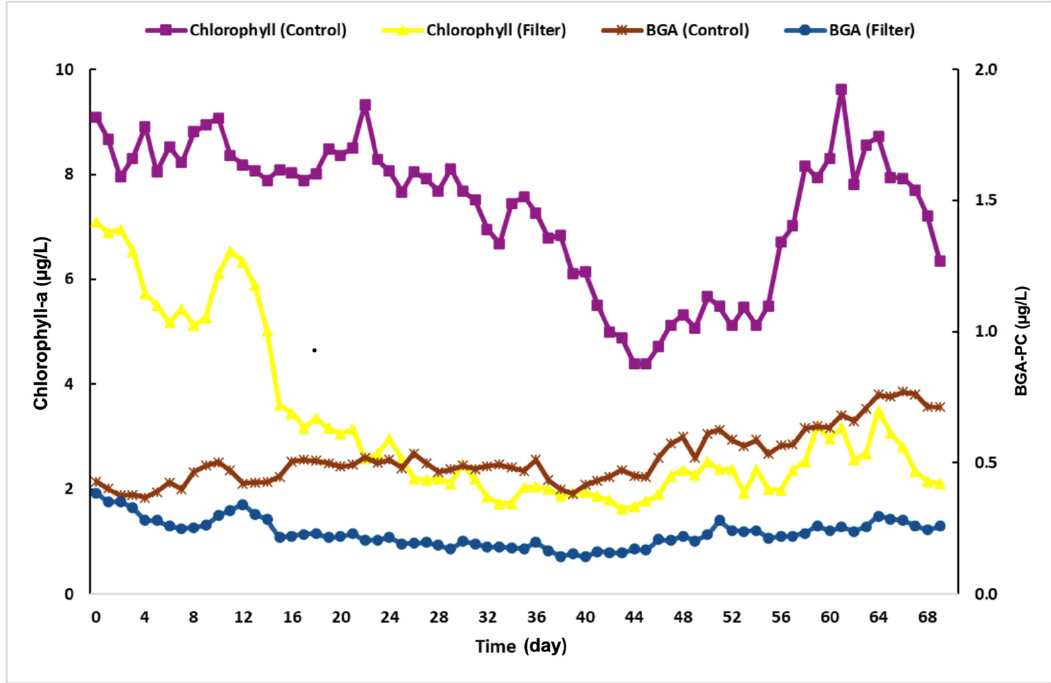
Figure 14. Chlorophyll-a ( µ g/L) and BGA-PC concentrations ( µ g/L) for the 2019 summer Figure 14 . Chlorophyll-a (µg/L) and BGA-PC concentrations (µg/L) for the 2019 summer in-situ ex- in-situ periment.